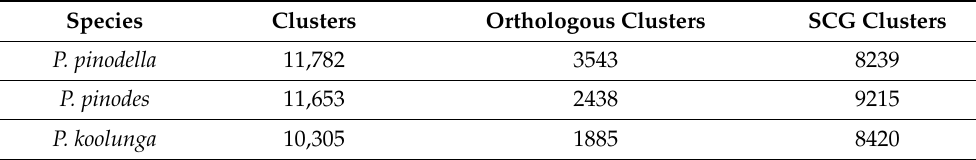
Figure 4. Pangenome analysis of the cDNA sequence (CDS) annotation for AB species. Core and pan-genome growth simulation plots for the AB species. Isolate CDS data were added in a random order by adding up six permutation experiments per species. P. koolunga (Panel ( a , b )), P. pinodella (Panel ( c , d )), and P. pinodes (Panel ( e , f )). Table 4. Interspecies orthologous statistics showing, the total number of clusters observed across the AB species, orthogroup clusters present in at least two species, and single-copy orthogroup (SCG) clusters in AB species. Species Clusters Orthologous